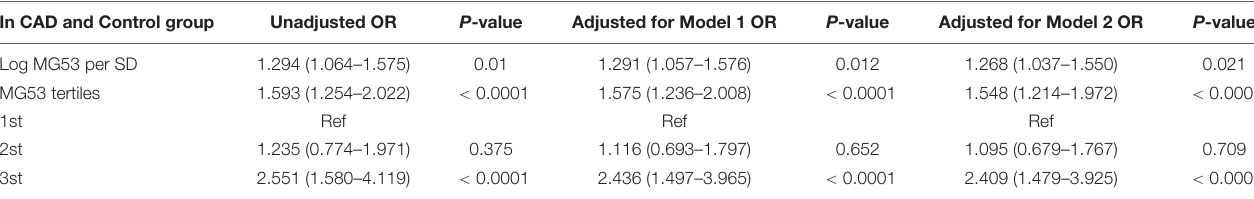
TABLE 2 | Associations of serum MG53 with the presence of CAD. In CAD and Control group